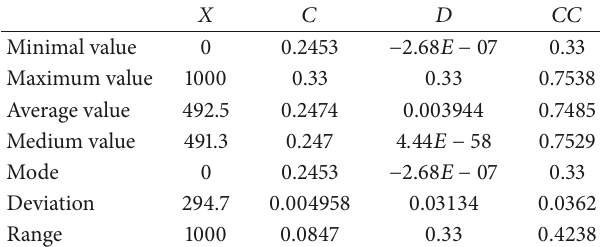
Figure 25: The state of population when 𝑋 = (0, 1000, 492.1, 490.7, 0, 294.4, 1000). Table 15: The statistical analyses of strategies 𝐶 , 𝐷 , and 𝐶𝐶 .